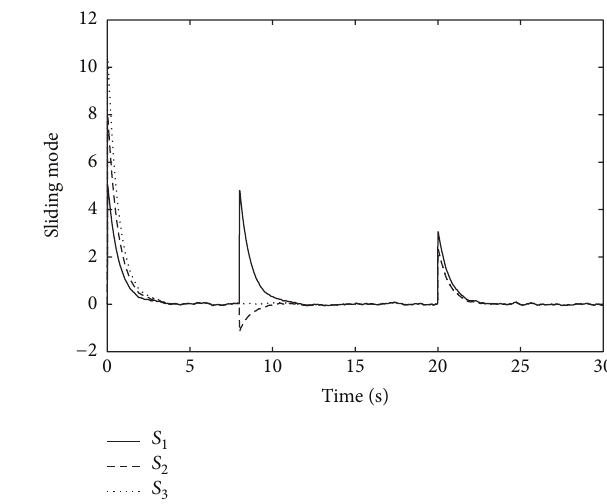
Figure 2: Velocity curves of vehicles.